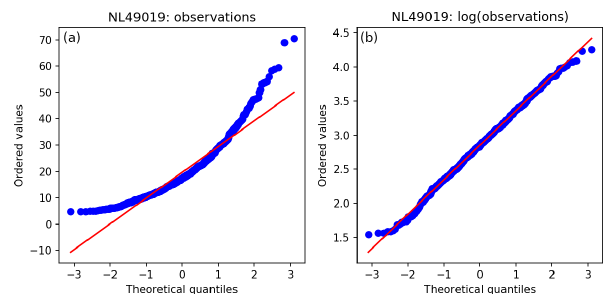
Figure 6. (a) Distribution of the NO 2 observations at reference sta- tion Oude Schans in July 2016 compared to a standard normal distri- bution. (b) The logarithm of the observed values correspond better to a Gaussian distribution, shown by the quantile value pairs being almost on a straight